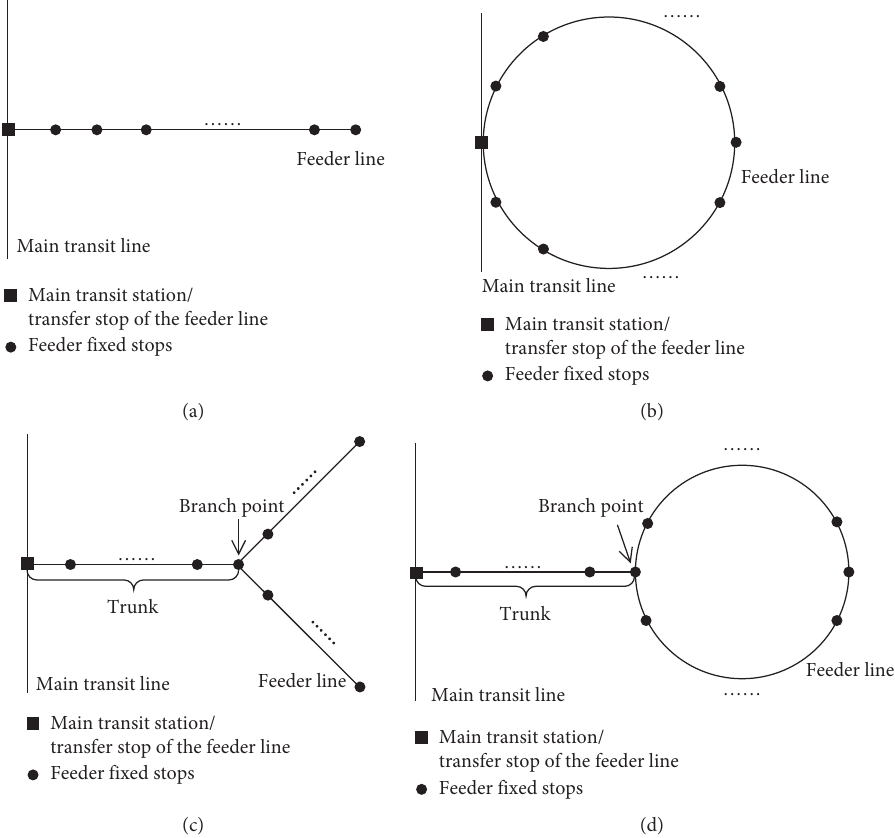
Figure 2: Shapes of feeder lines. (a) Linear line. (b) Loop line. (c) Y-shaped line. (d) Spoon-shaped line.